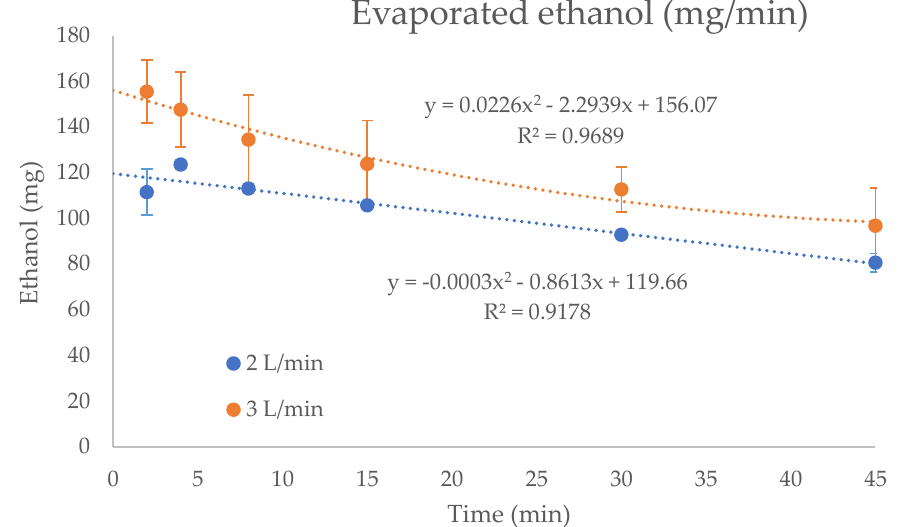
Figure 5. Amount of ethanol (mg) in the vapor phase of oxygen generated in the humidifier, during the 45 minutes of treatment, at the flow rates of 2 L/min and 3 L/min.